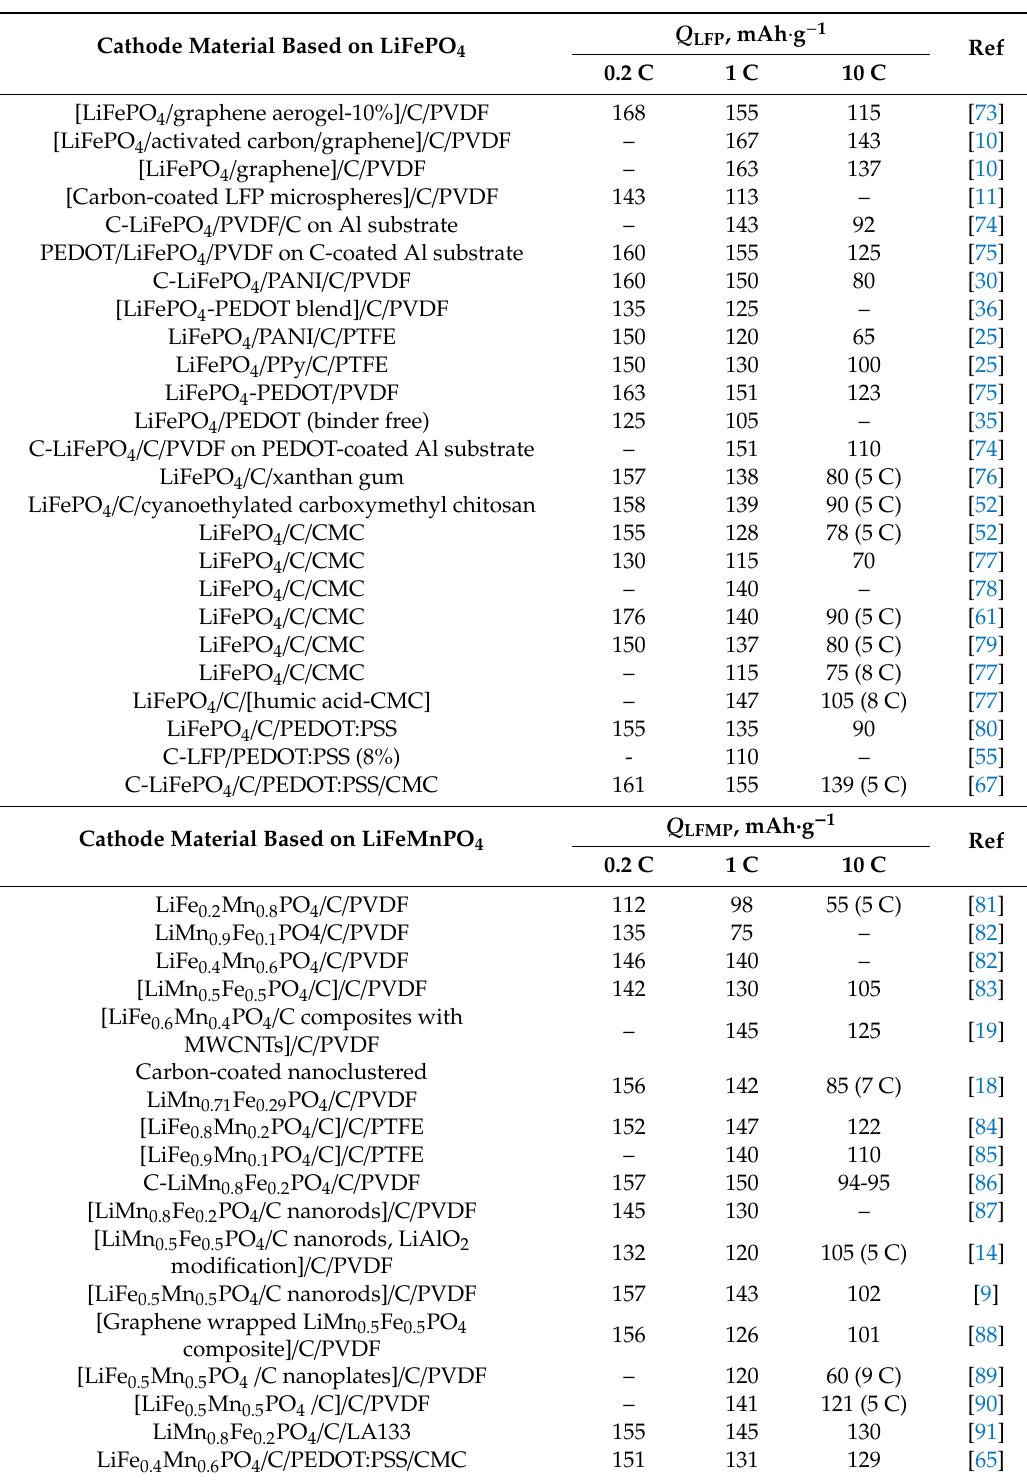
Table 3. Specific capacities of di ff erent electrode materials. Q electroactive material , capacities normalized by electroactive mass (mAh · g − 1 ). (In the case of estimates from graphical dependencies, given values may be